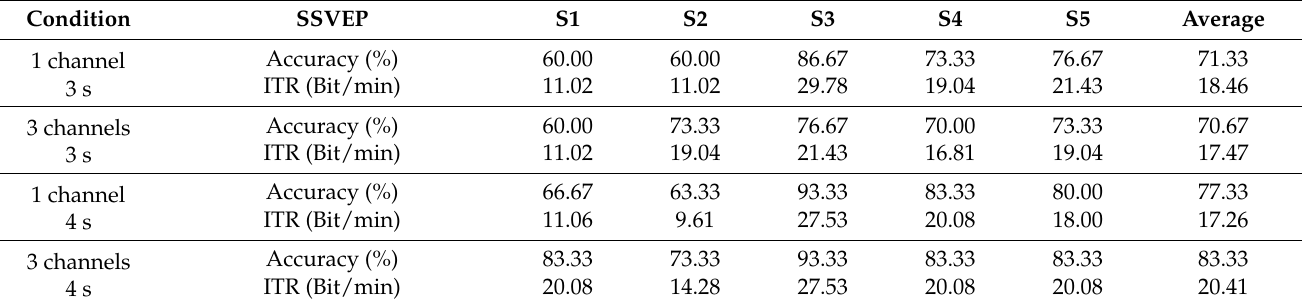
Table 1. Performance (Accuracy, ITR 1 ) of steady SSVEP 2 according to conditions (used number of channels, epoch period).